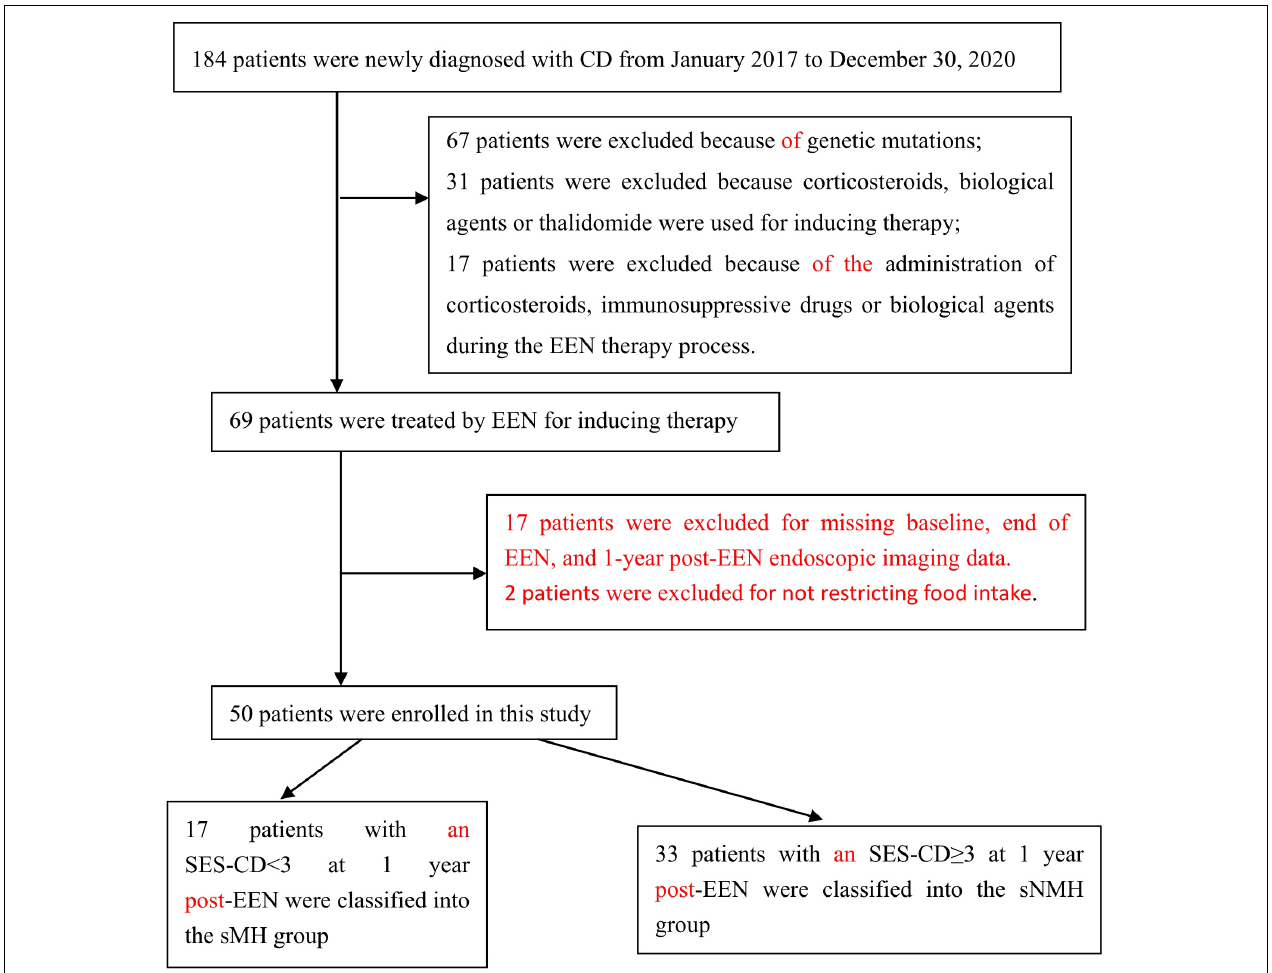
FIGURE 1 | Flow diagram of patient inclusion in this